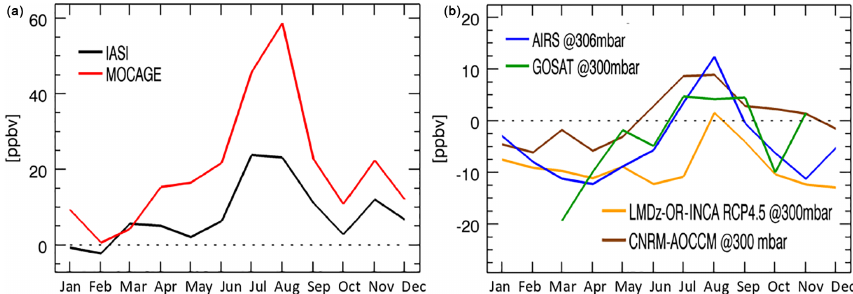
Figure 25. Seasonal evolution of the difference in CH 4 fields between the eastern and western Mediterranean basins: (b) around 300hPa as measured by AIRS (blue) and GOSAT (green) and as calculated by LMDz-OR-INCA (yellow) and CNRM-AOCCM (brown), and (a) in the total column as measured by IASI and calculated by MOCAGE (adapted from Ricaud et al.,